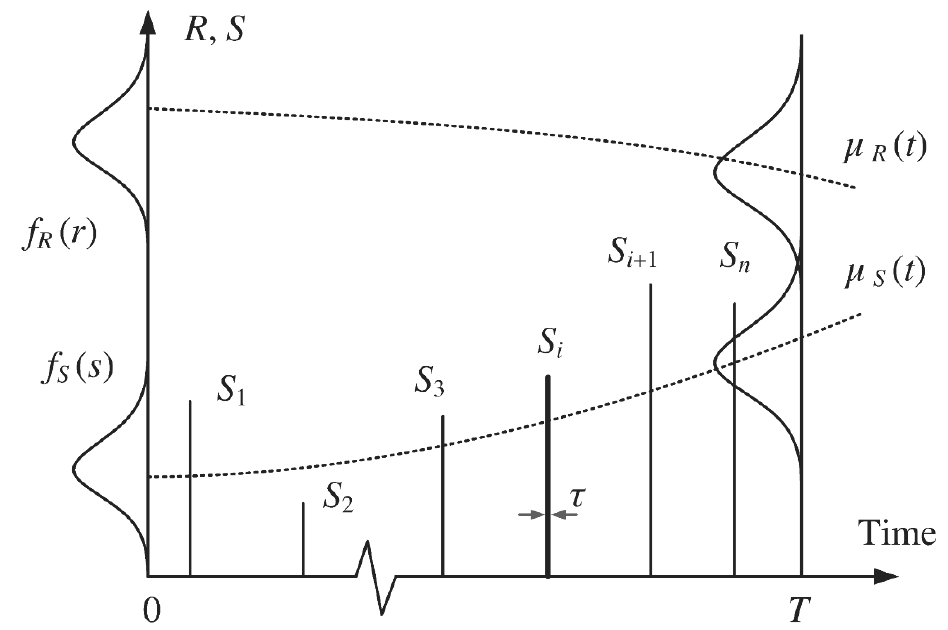
Figure 1. Schematic representation of load process and degradation of resistance. See [11] for more details. Reprinted with permission from [11]. Copyright 2020, Elsevier.